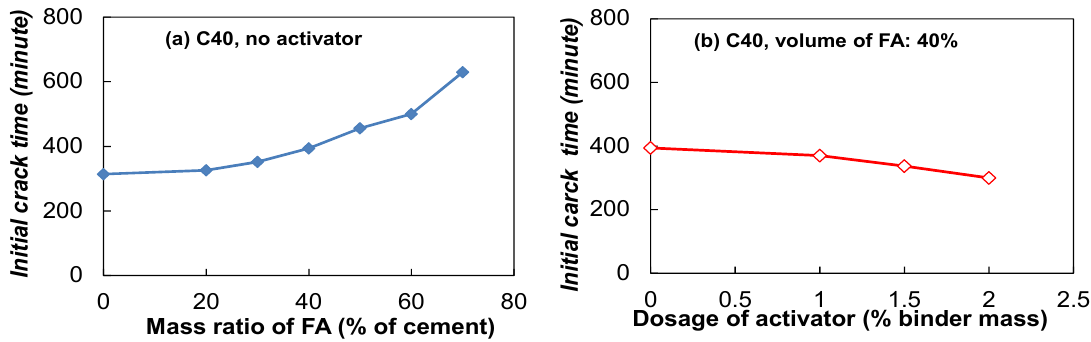
Figure 10. Effects of FA contents and the dosage of AC on the initial crack time of FAC.